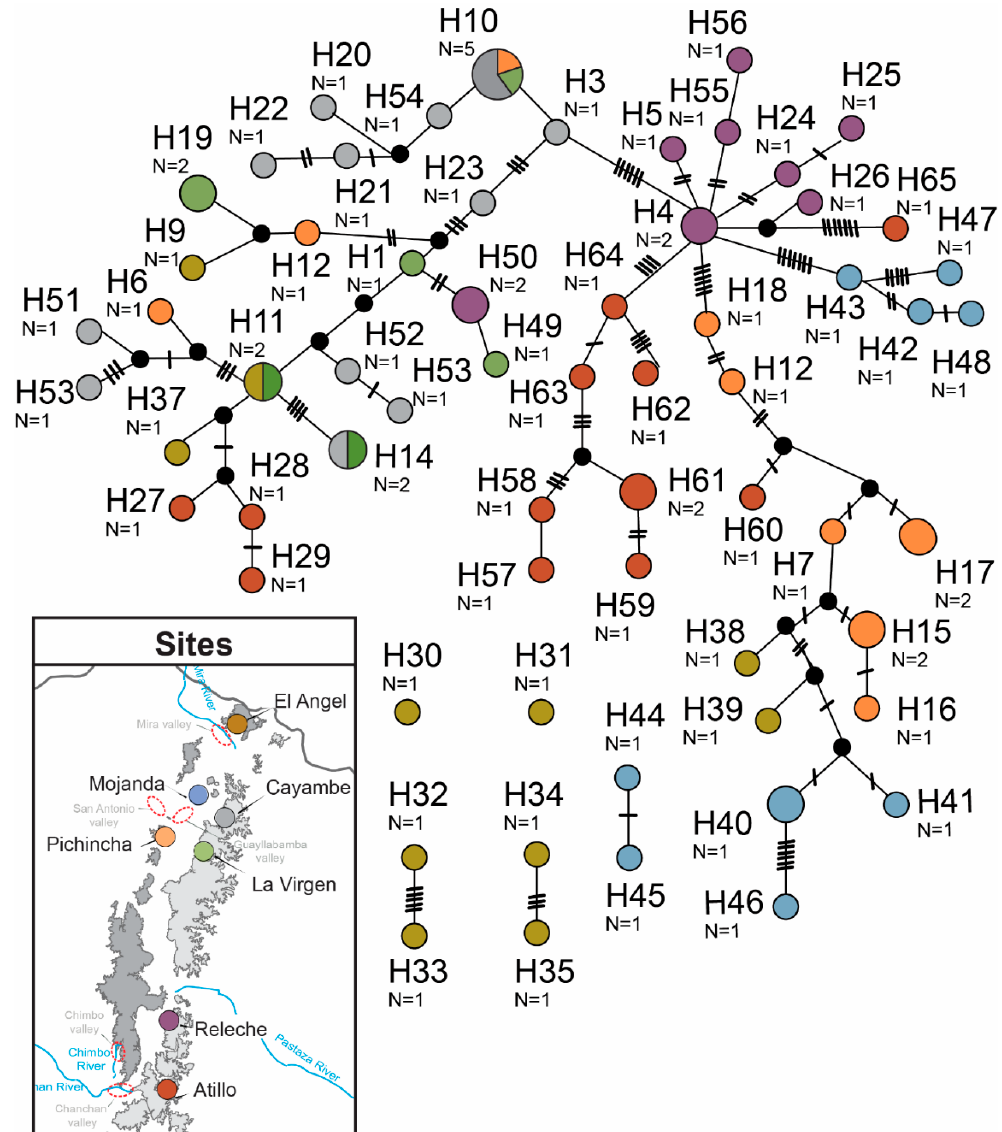
Figure 3. TCS haplotype networks for the nuclear gene, wingless of Panabachia .